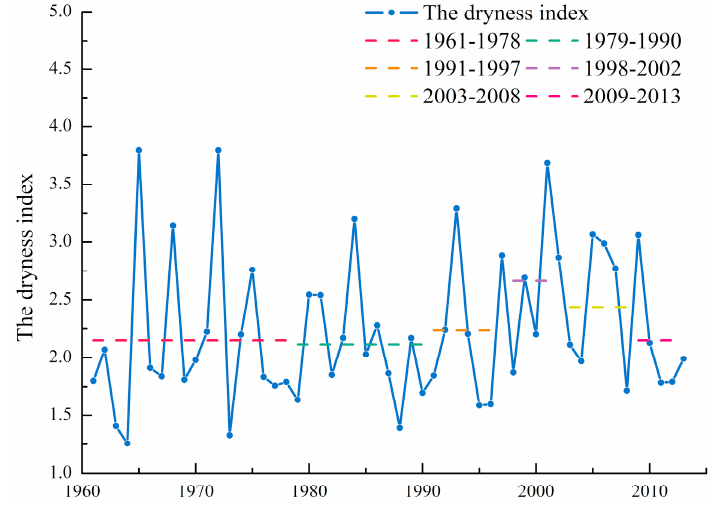
Figure 13. Variation in the dryness index from 1961 to 2013.